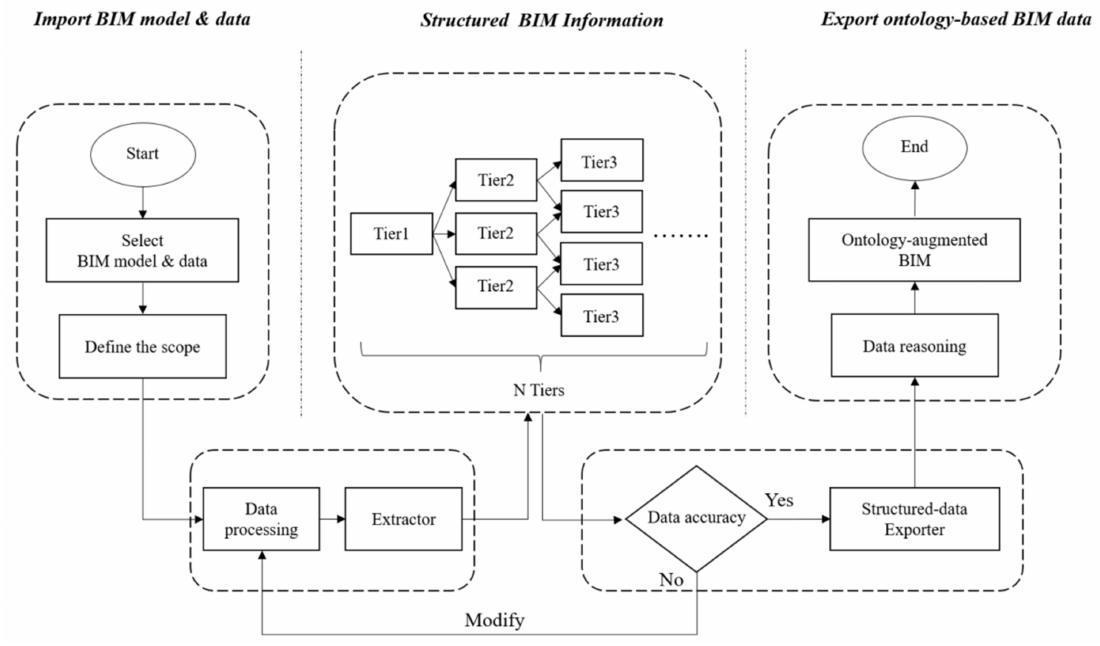
Figure 2. The process of structuring BIM